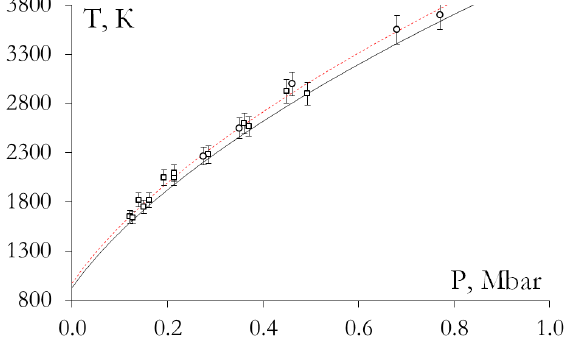
Figure 7: Melting curve for Pb. The solid curve is the present calculation; the experimental data are indicated by  ,  , and  [17-19]. The dashed curve is Simon’s melting